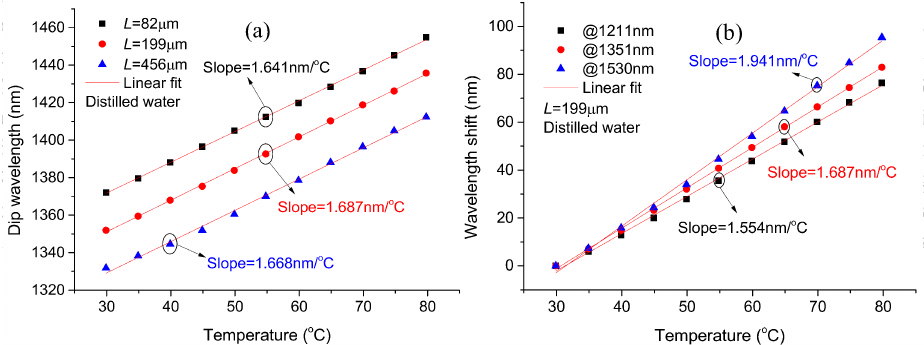
Figure 6. ( a ) Spectral dip wavelength as functions of environmental temperature for the proposed device with different cavity lengths of 82 µ m, 199 µ m, and 456 µ m; ( b ) Spectral dip wavelength shift as functions of environmental temperature at different dip wavelength positions for the device with cavity length 199 µ m.